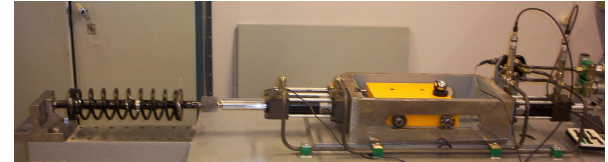
Figure 2: Experimental setup for NHMS.